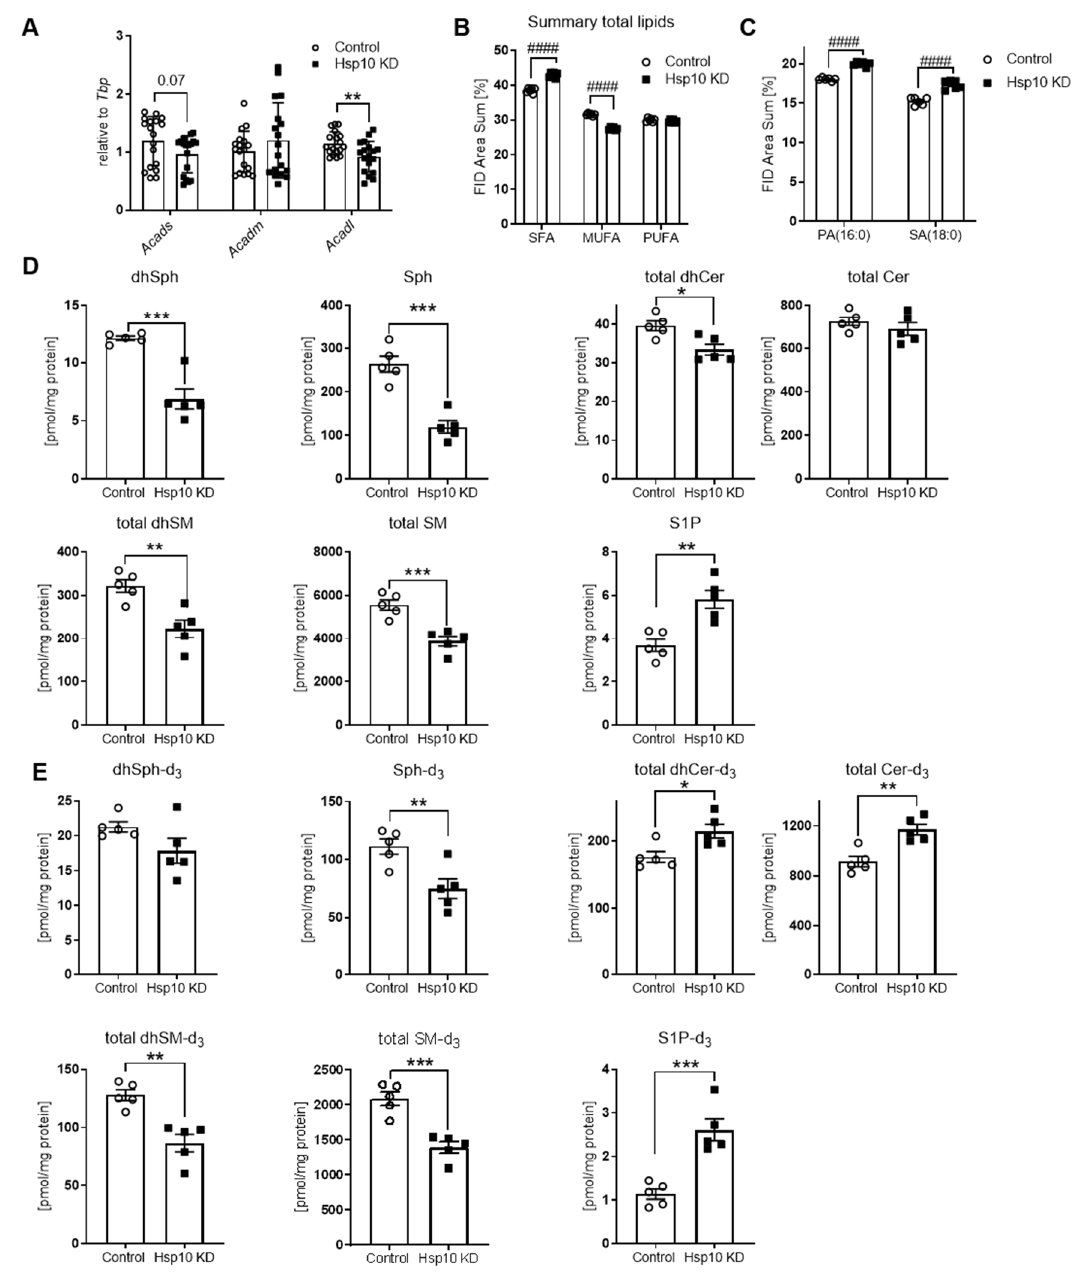
Figure 4. Hsp10 KD in hypothalamic cells induces dysregulated lipid metabolism. ( A ) mRNA expression of acyl–CoA dehy- drogenases Acads, Acadm, Acadl of control and Hsp10 KD cells, n = 18. ( B ) Fatty acid analysis of cell total lipids in Hsp10 KD and control cells; shown is the area summary of saturated fatty acids (SFA), monounsaturated fatty acids (MUFA), and polyunsaturated fatty acids (PUFA) in percent, n = 6. ( C ) Fatty acid analysis of cell total lipids in Hsp10 KD and control cells; shown is the increase in area summary of palmitic acid (PA) and stearic acid (SA) in Hsp10 KD cells in percent, compared to control, n = 6. ( D ) Quantification of sphingolipids by HPLC–MS/MS; shown are dihydrosphingosine, sphingosine, total dihy- droceramides, ceramides, dihydrosphingomyelin, sphingomyelin, sphingosine-1-phosphate and ( E ) dihyrosphingosine-d 3 , sphingosine-d 3 , total dihydroceramide-d 3 , ceramide-d 3 , diyhdrosphingomyelin-d 3 , sphingomyelin-d 3 and sphingosine-1- phosphate-d 3 of Hsp10 KD and control cells n = 5. *, p < 0.05, **, p < 0.01, ***, p < 0.001 after two-tailed Student’s t -test. ####, p < 0.0001 after two-way ANOVA and Sidak’s multiple comparisons test. All data are presented as mean ±